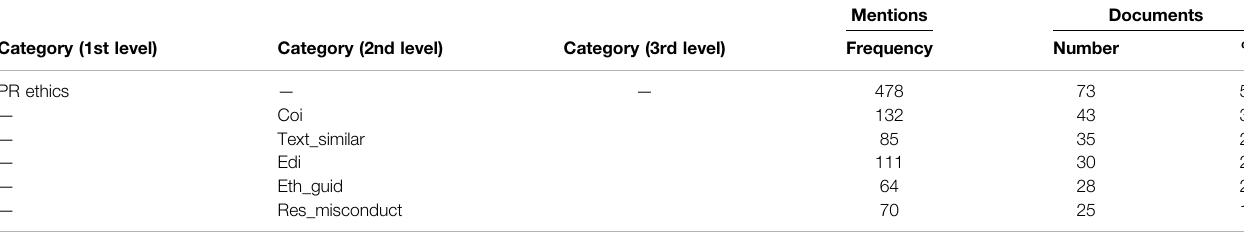
TABLE 5 | Peer review ethics categories (found in more than 10% of the documents).